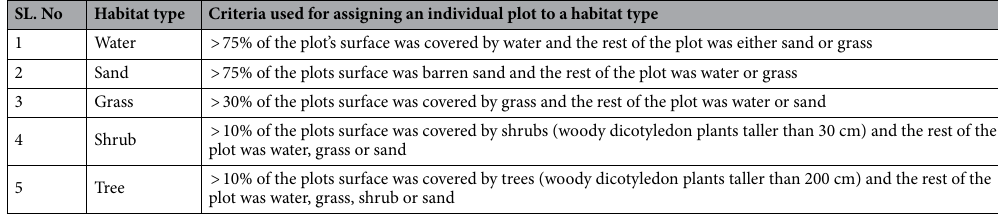
Table 3. Habitat groupings, based on surface features measured in a habitat